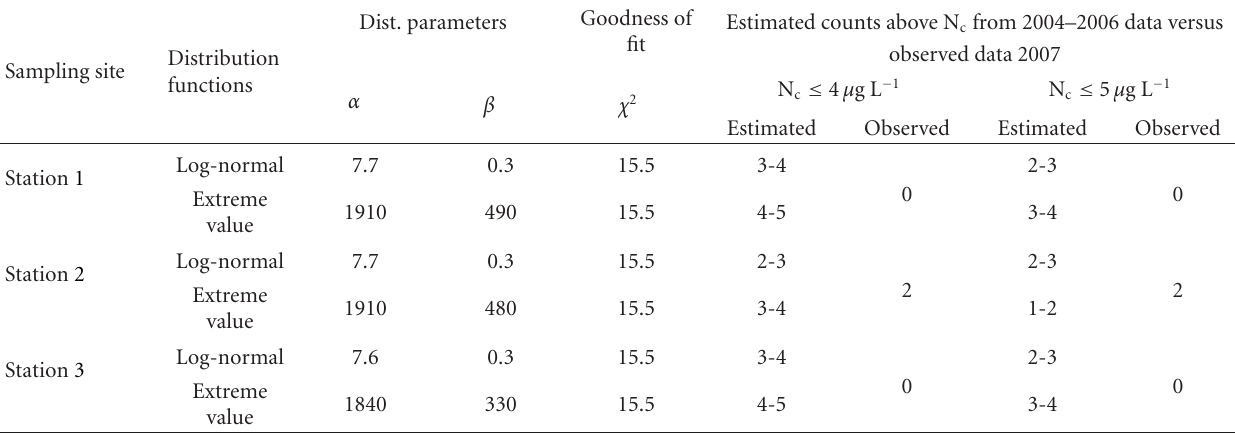
Table 4: Parameters, goodness of fit and estimated probability of microcystin concentration above specified values for each distribution function versus observed frequencies at each sampling